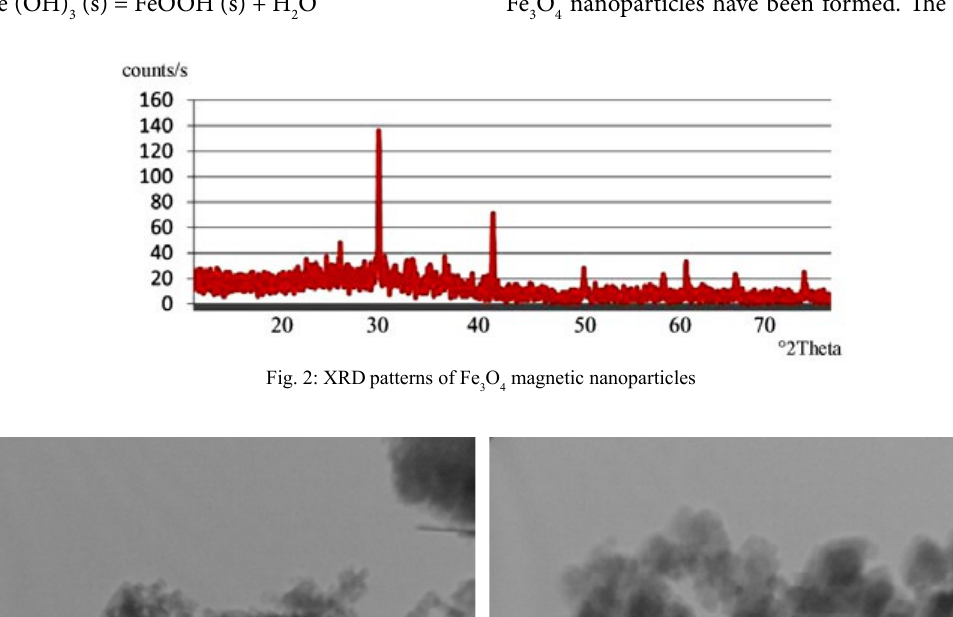
Fig. 3: TEM images of Fe Figure 3: TEM images of Fe 3 O 4 MNPs